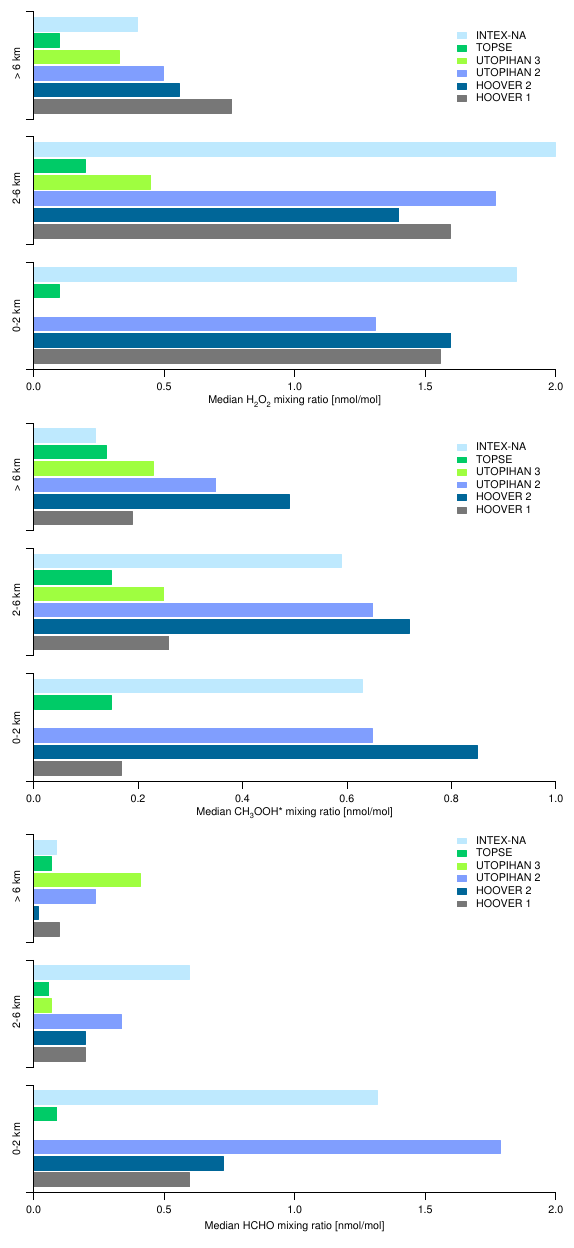
Fig. 5. Comparison of the TOPSE (March/April 2000), INTEX- NA (July 2004), UTOPIHAN 2 (July 2003), UTOPIHAN 3 (March 2004), HOOVER 1 (October 2006) and HOOVER 2 (July 2007) measurement campaigns. The median values for the respective al- titude regions are shown as bars for H 2 O 2 , CH 3 OOH ∗ and HCHO.